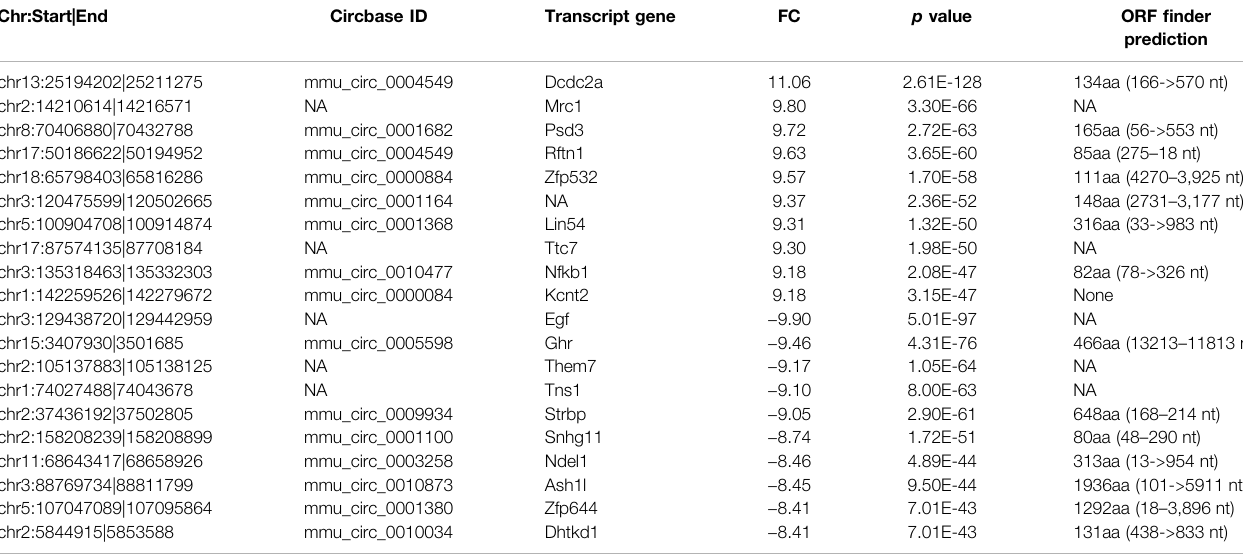
TABLE 2 | The top 10 most upregulated and downregulated